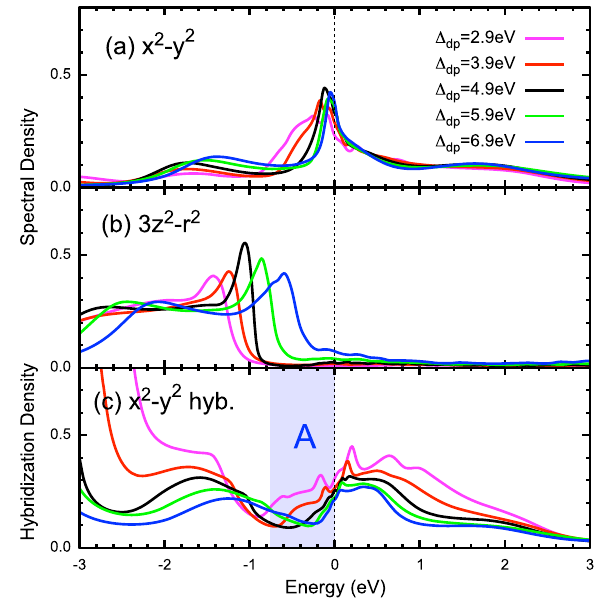
identify as the optimal parameter choice. Both the LDA and LDA þ DMFT yield a metallic state with the Ni x 2 − y 2 orbital character dominating around the Fermi level. This general picture is valid in the entire range of studied Δ ¼ 2 . 9 – 6 . 9 eV. In Fig. 2, we show the depend- dp ence of Ni x 2 − y 2 and 3 z 2 − r 2 spectra on Δ . Increasing dp Δ corresponds to an upward shift of the bare Ni 3 d site dp energies, which is indirectly reflected in the shift of the 3 z 2 − r 2 band. The x 2 − y 2 peak at the Fermi level, rather